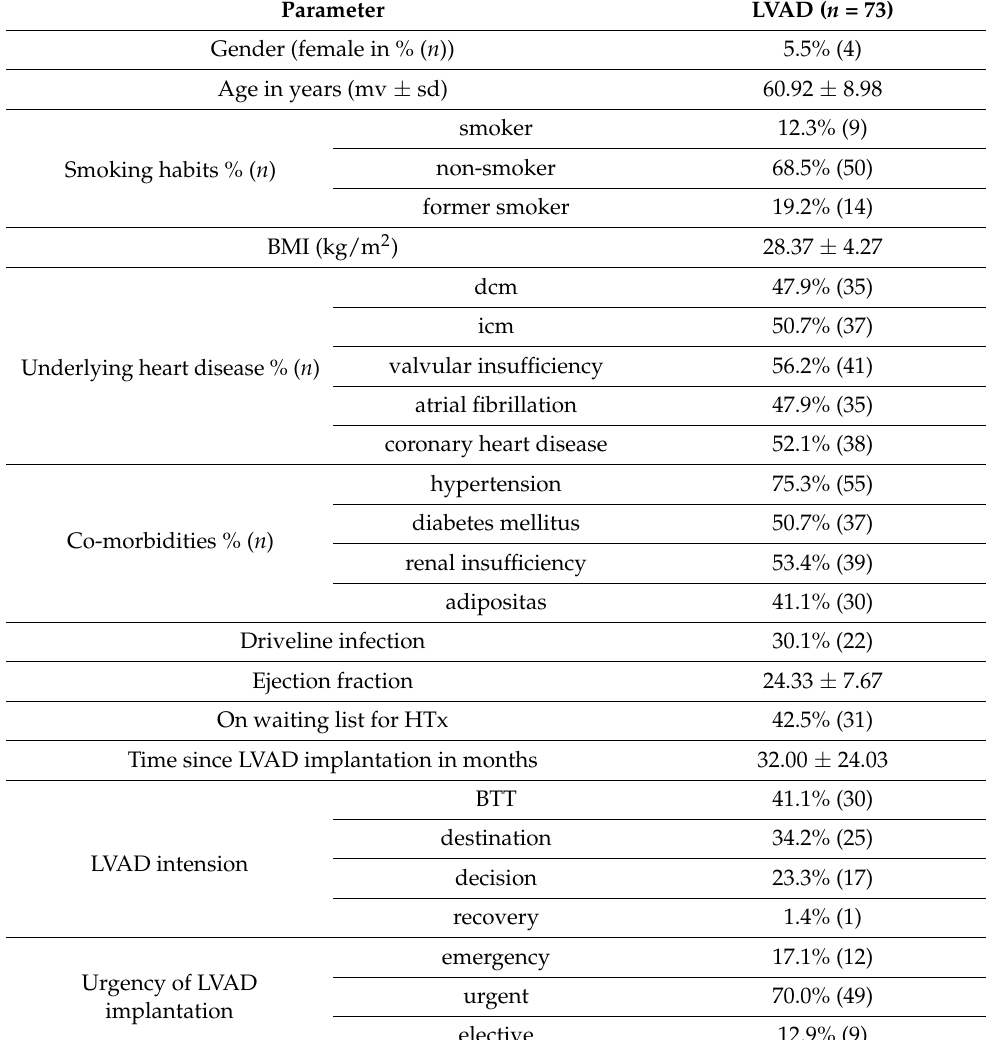
Table 1. Patient